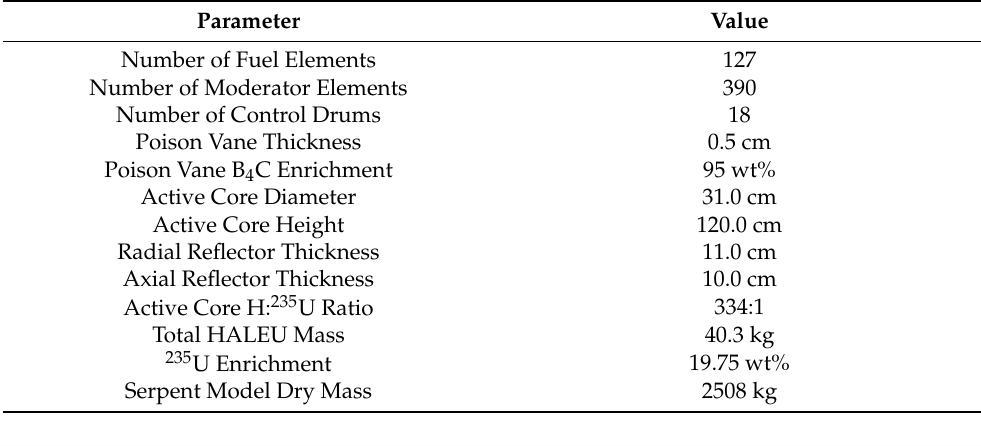
Table 1. Key design parameters.